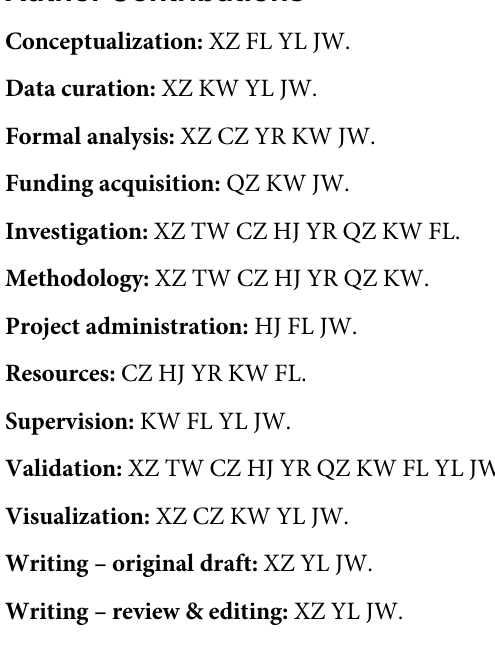
S1 Table. Primers used in this